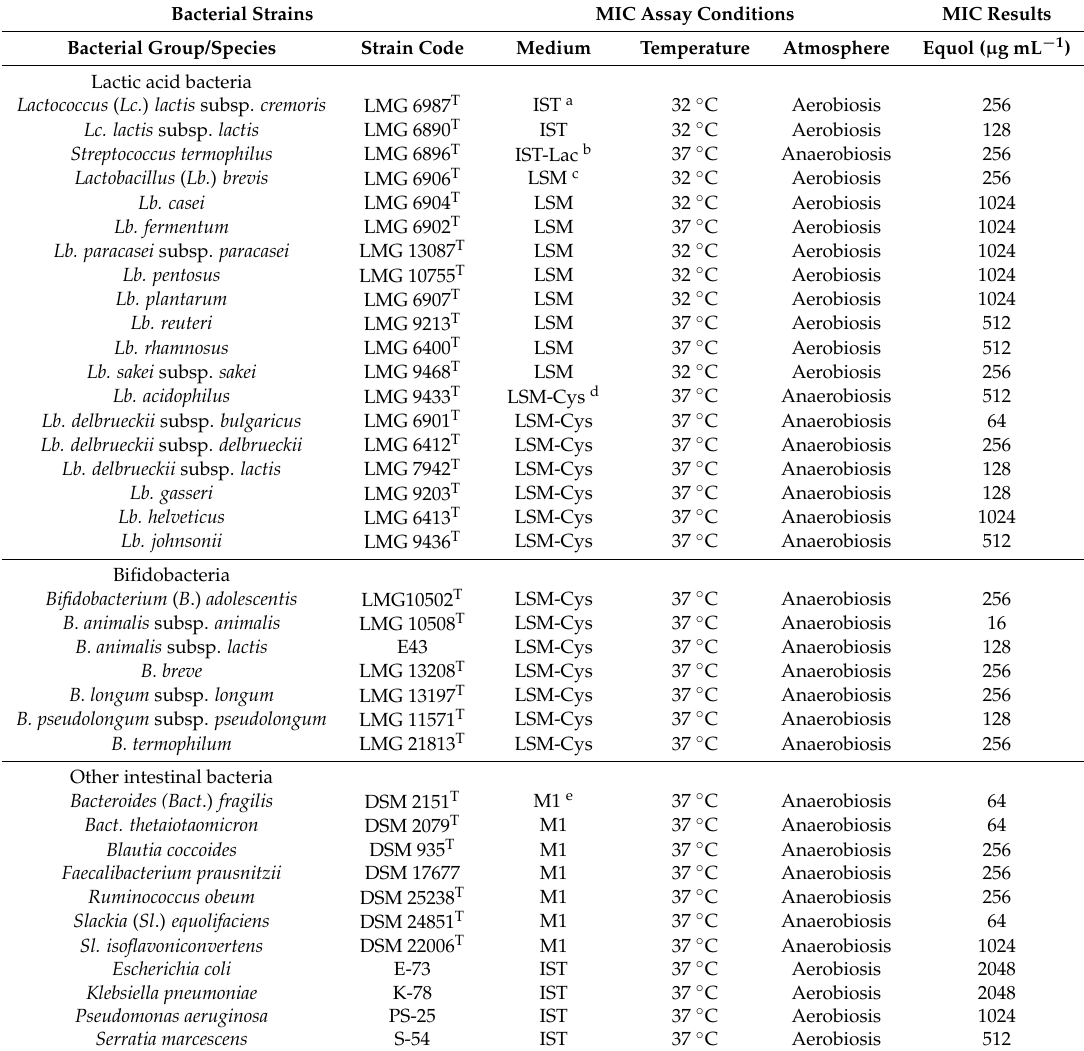
Table 1. Bacterial strains, assay conditions for the minimum inhibitory concentration (MIC), and MIC results of equol to the intestinal species and strains under